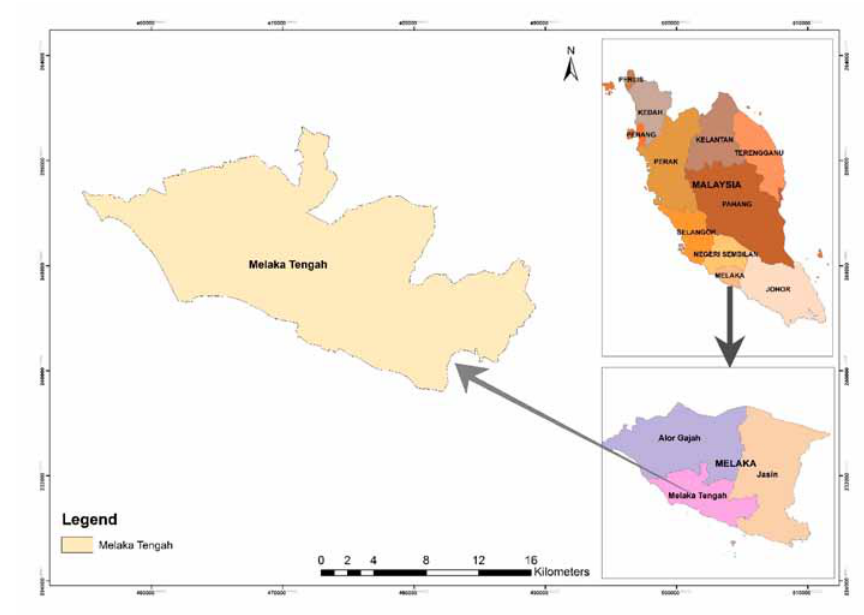
Fig. 1. Location map of the study